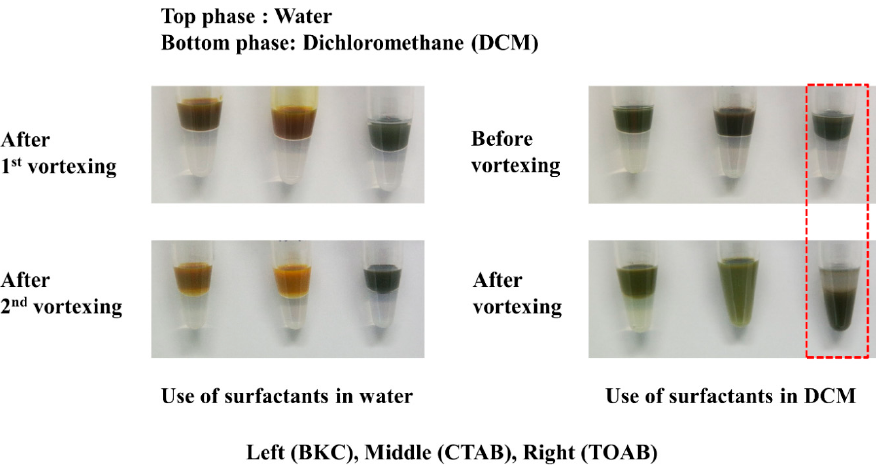
Figure 1. Phase transfer of AgNSs from water to dichloromethane by different cationic surfactants (BKC, CTAB, and TOAB).